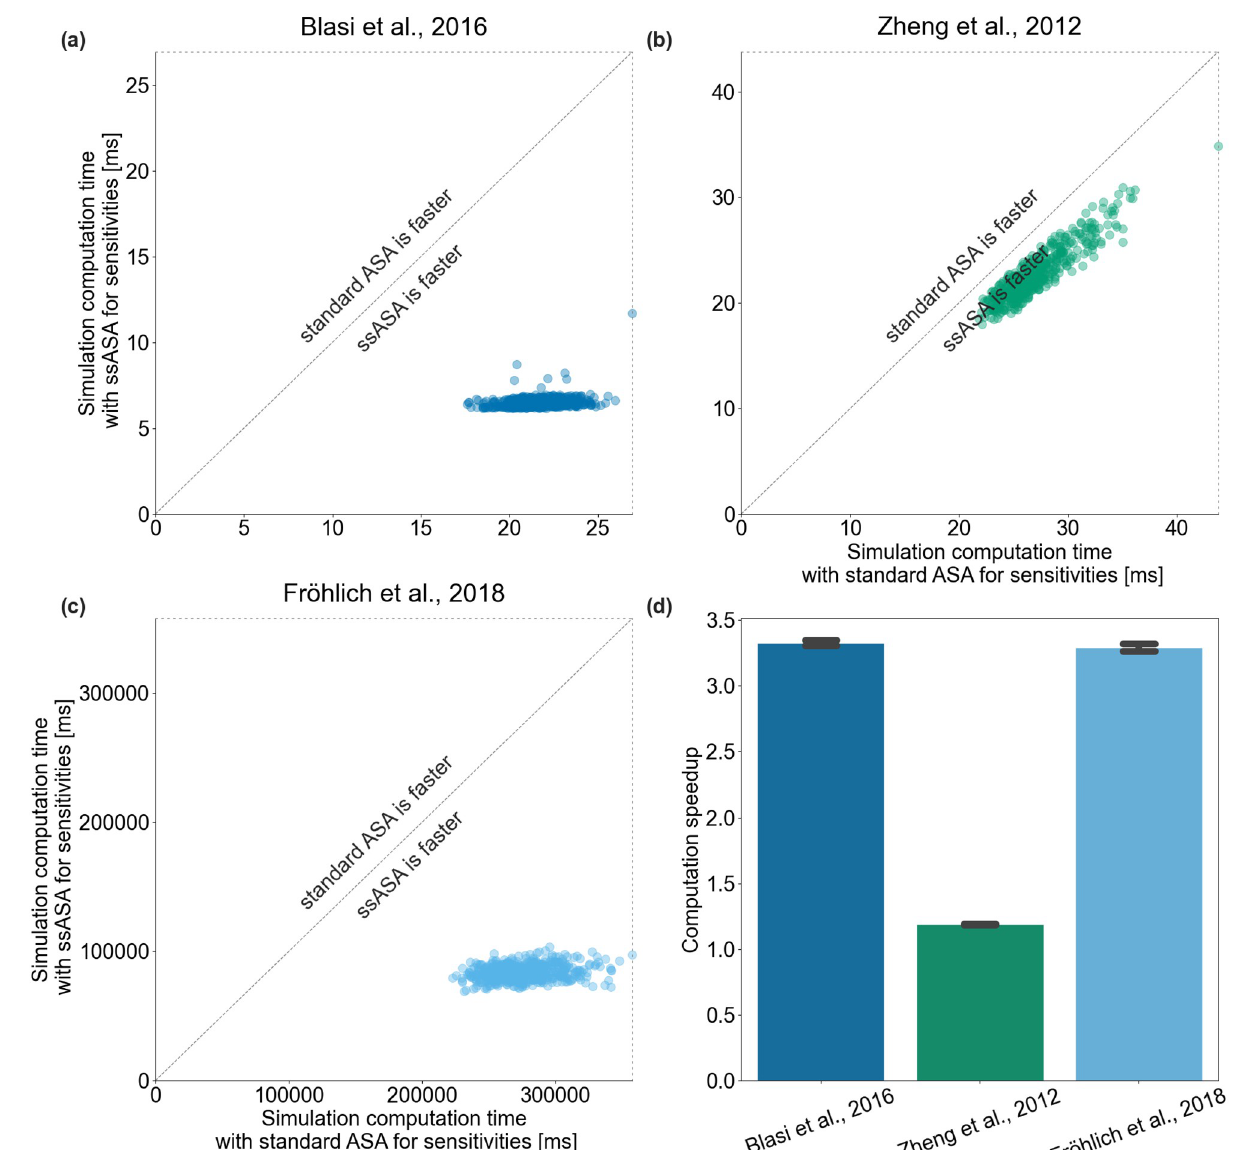
Fig 4. Simulation efficiency of the proposed method. Each point corresponds to a total simulation time with ASA (x-axis) and ssASA (y-axis) for sensitivities computation. Points on the diagonal correspond to simulations that took equal time with both approaches. (a) Blasi et al ., 2016, (b) Zheng et al ., 2012 and (c) Fro¨hlich et al ., 2018 models. (d) Computation speedup of simulations using ssASA for sensitivities computation compared to using standard ASA. Each bar height corresponds to a mean of computation speedups of all simulations and each error bar corresponds to the sample standard